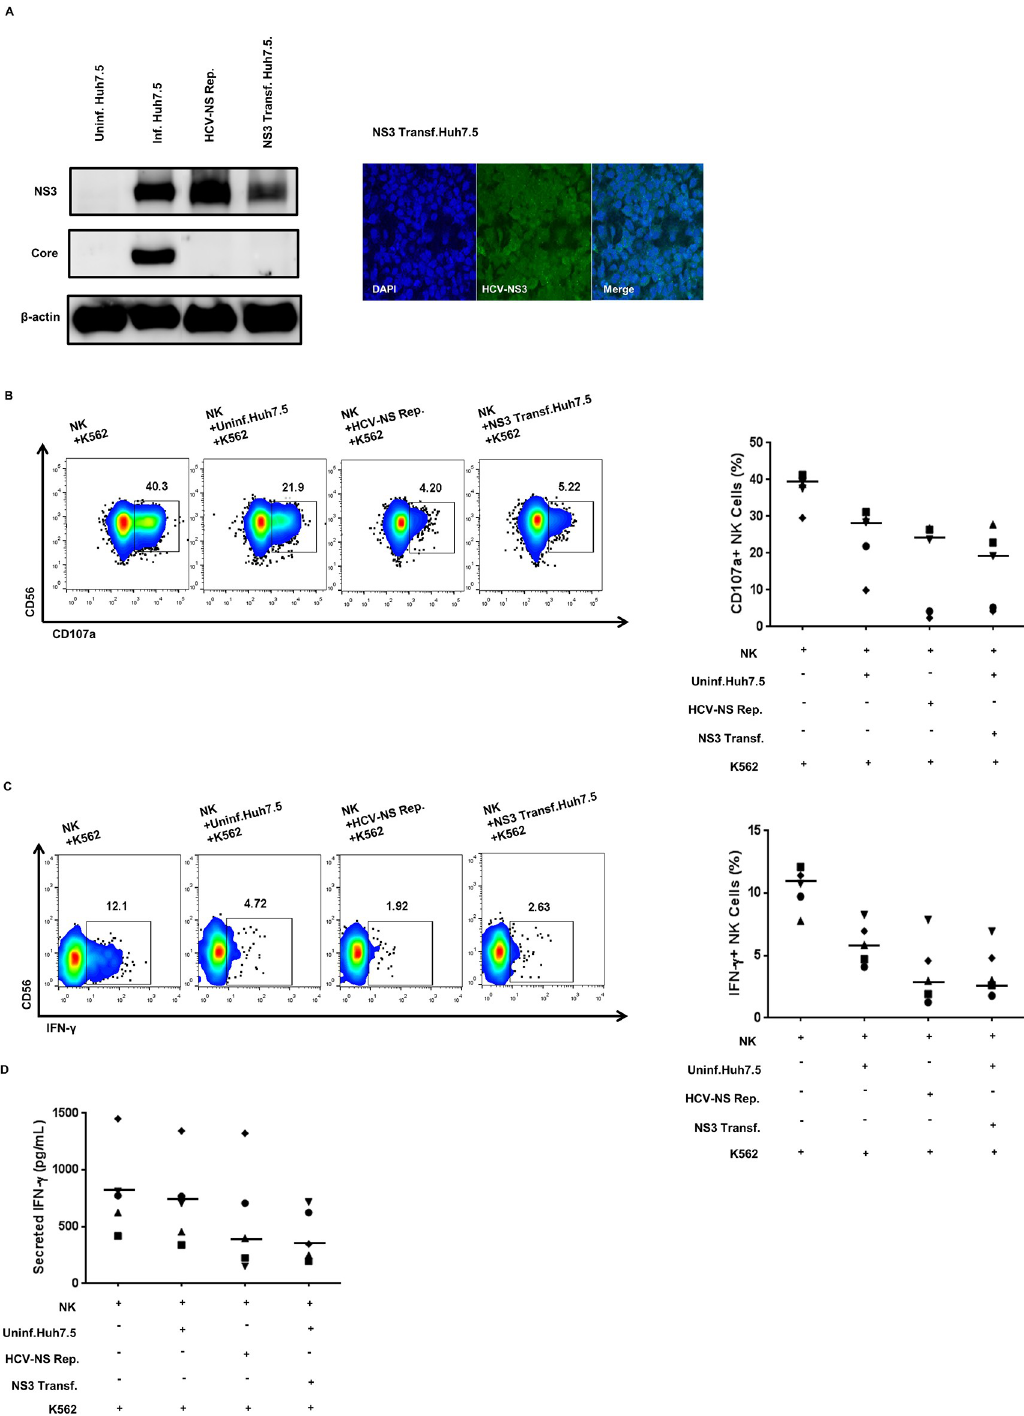
Fig 2. HCV-NS replicon and HCV-NS3-transfected Huh-7.5 cells attenuate NK cell functions. (A) Expression levels of HCV NS3 protein in HCV-NS repliconcells and HCV-NS3-transfected Huh-7.5 cells. Western blotting ( left panel )was performed using anti-HCV-NS3 and anti-HCV-Core antibodies. As a loadingcontrol, human anti- β -actin was used. Confocalmicroscopy ( right panel )was performed after 48 h of NS3 transfection. Transfected Huh-7.5 cells were fixed and stainedwith HCV-NS3 antibody ( green )and 4 0 ,6-diamidino-2-phenylindole (DAPI; blue ). Transient transfection was carried out using Lipofectamine 2000(Invitrogen)(B) NK cell degranulation after co-cultivation with NS3-transfected Huh-7.5cells. NK cells were pre-incubated with uninfectedcells, HCV-NS repliconcells,